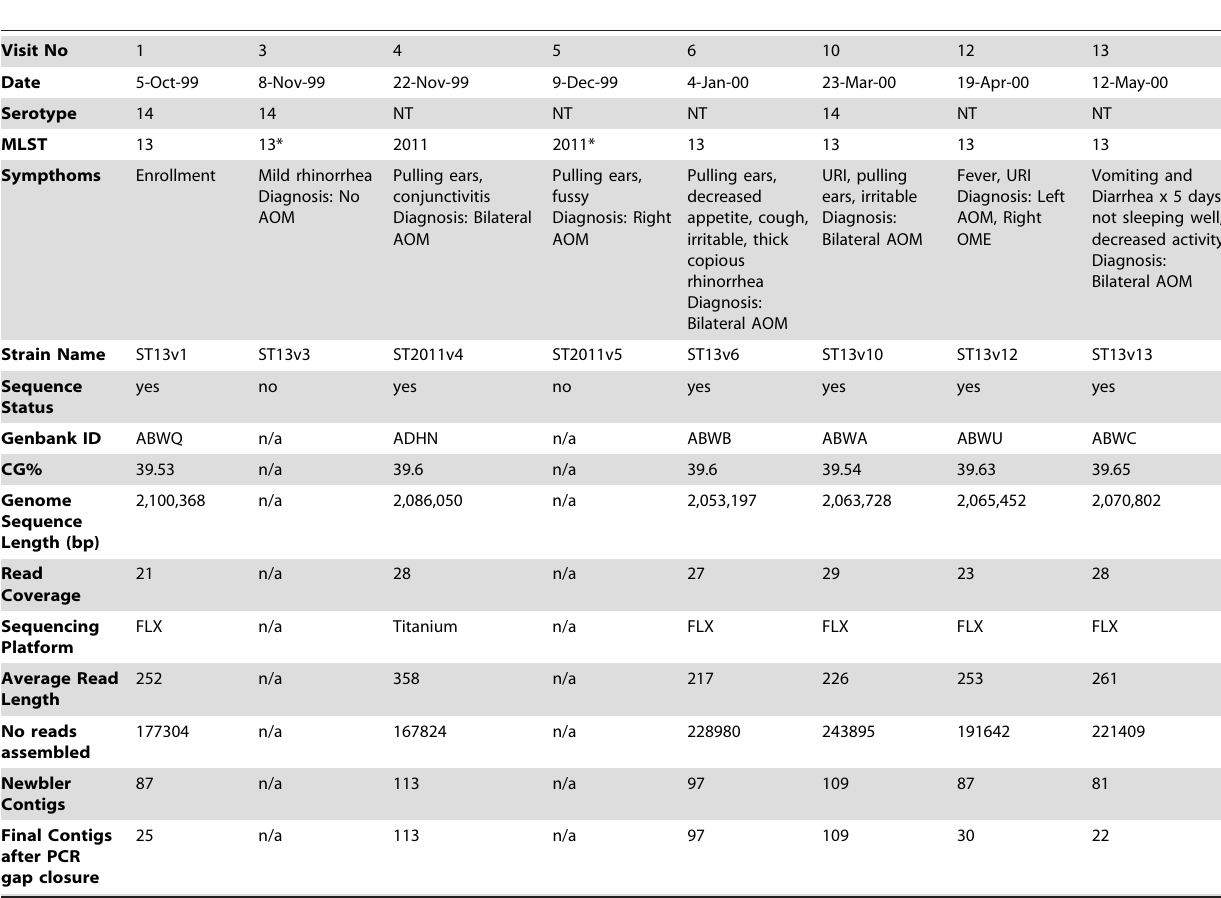
Table 1. Patient’s clinical history and clinical, sequencing and assembly information on the S. pneumoniae strains.